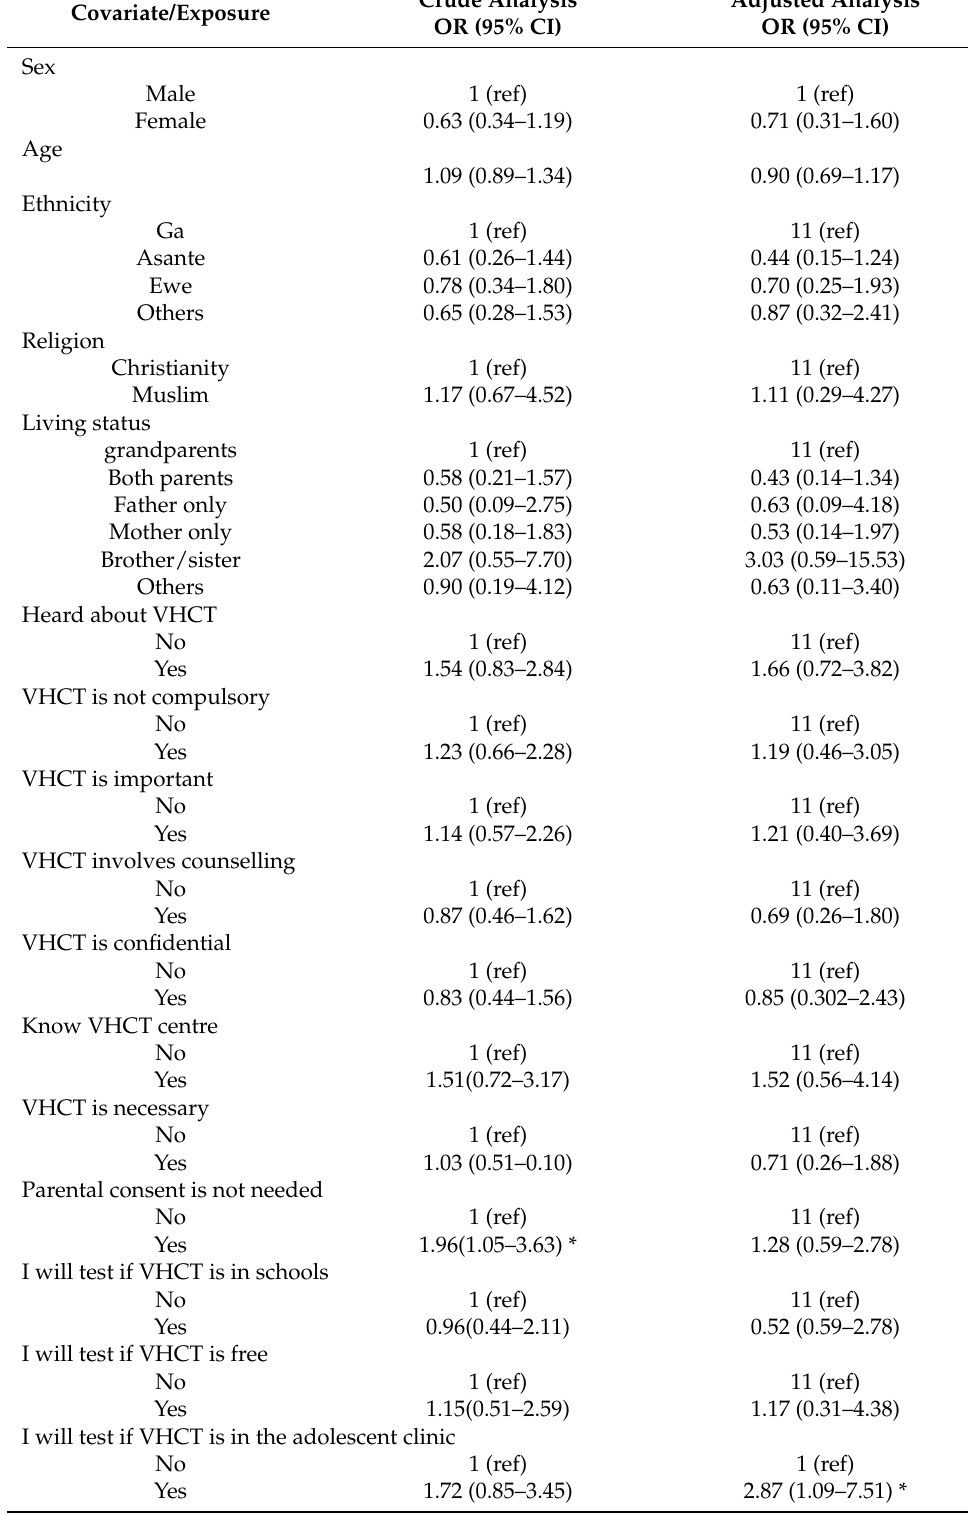
Table 4. Factors associated with the uptake of VHCT services among young people in the Tema